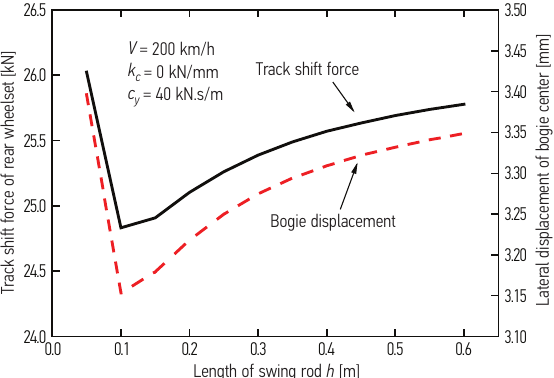
Fig. 21. The simulation results of locomotive 1 when the k c is 0 kN/mm